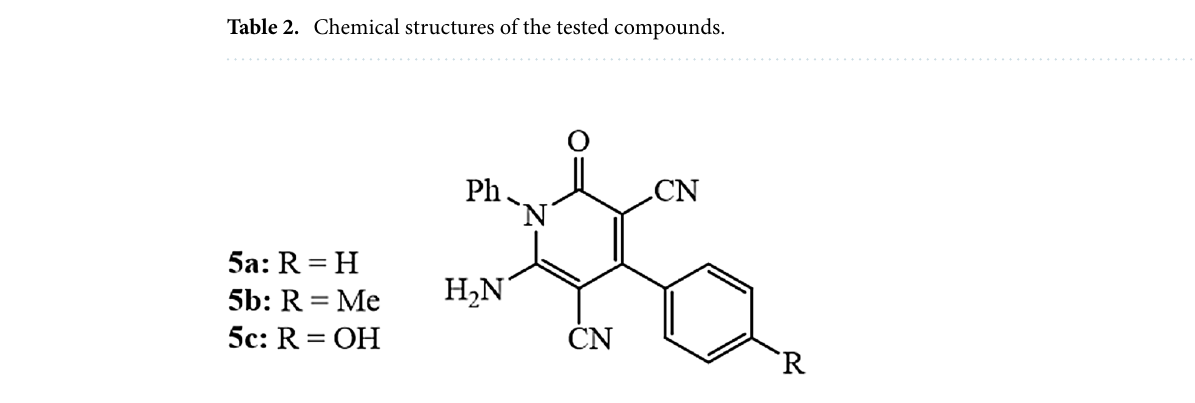
Figure 1. Molecular structure of investigated carbonitrile